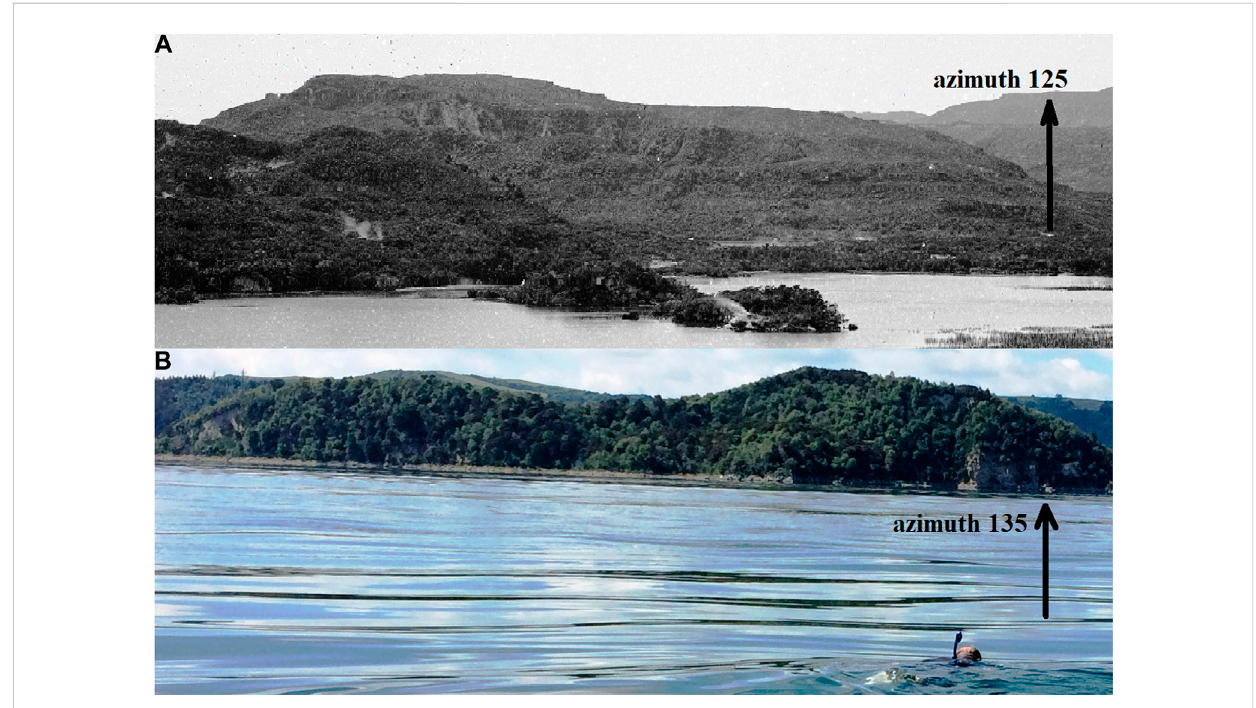
FIGURE 6 Rangipakaru Hill in 1885 (A) Burton Bros. Patiti Island in 2016 (B) . (Ingrid Fisher). Note the 125 ° and 135 ° azimuths to orient the images. The author is scoping our fi rst scuba dive off Tarata